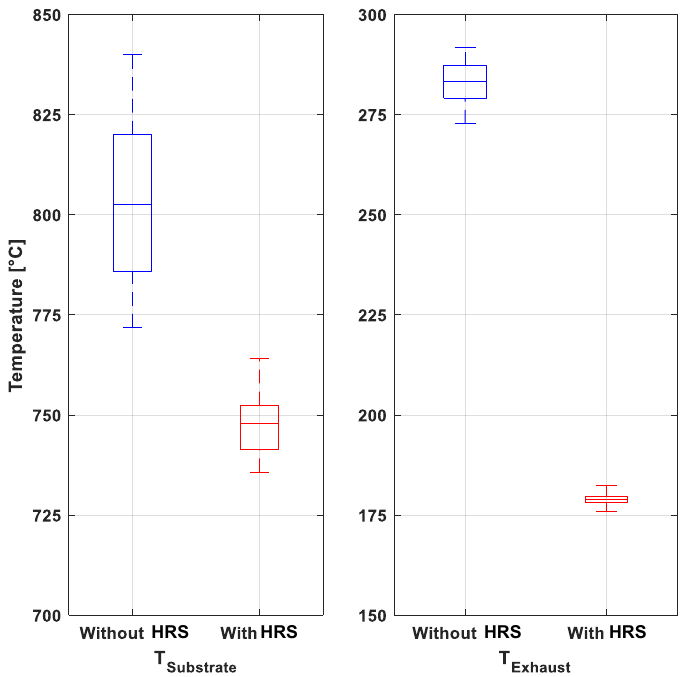
Figure 4. Comparison of the reactor with and without the Heat Recirculation System (HRS) composed of top and bottom units. The implemented HRS decreased the exhaust temperature by ∼ 100 ◦ C averaged over the two units. Air flow was 6000 mL/min through 2SSC substrates.